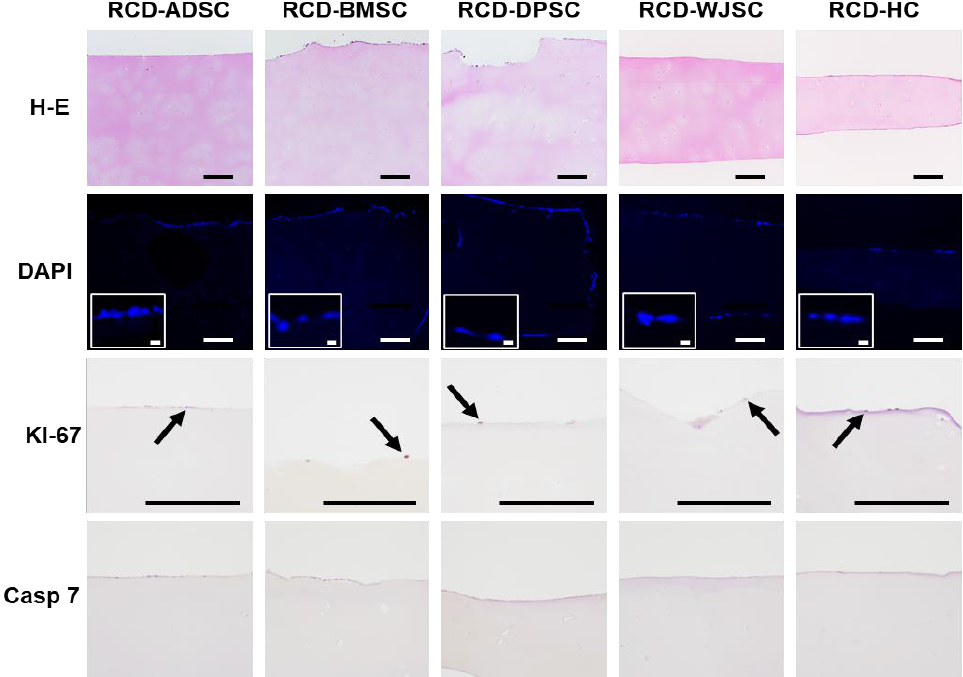
Figure 5. Histological analysis of recellularized cartilage disks (RCD) maintained in ex vivo culture, with H-E, DAPI and immunohistochemistry for KI-67 and Caspase 7 (Casp 7). Representative cells with positive staining for DAPI are shown in higher magnification inserts, and some KI-67-positive cells are highlighted with arrows. RCD-ADSC: RCD recellularized with adipose tissue MSC; RCD-BMSC: RCD recellularized with bone marrow MSC; RCD-DPSC: RCD recellularized with dental pulp MSC; RCD-WJSC: RCD recellularized with umbilical cord Wharton Jelly MSC; RCD-HC: RCD recellularized with human chondrocytes. Scale bars: 200 µ m (20 µ m for the high-magnification DAPI